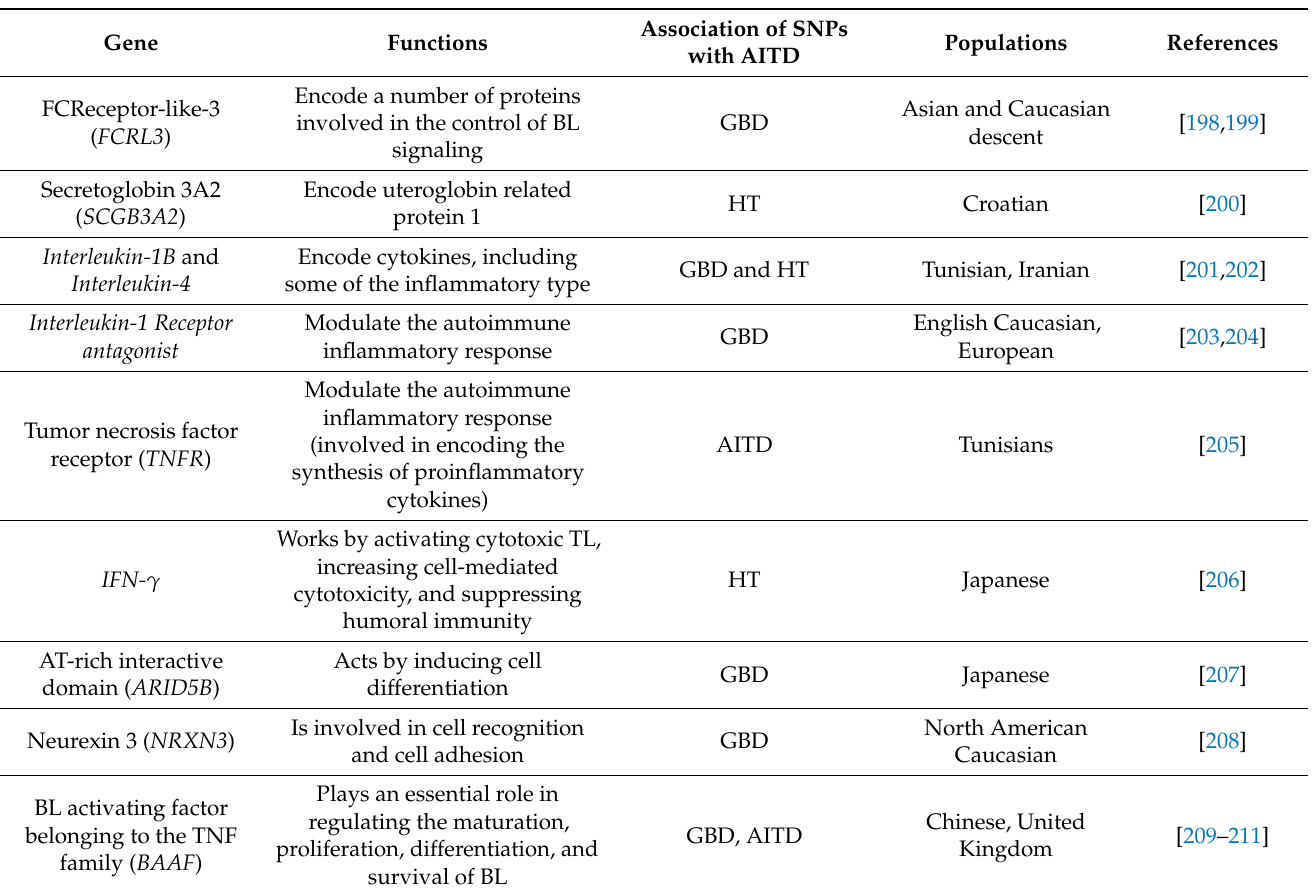
Table 4. Other candidate genes involved in